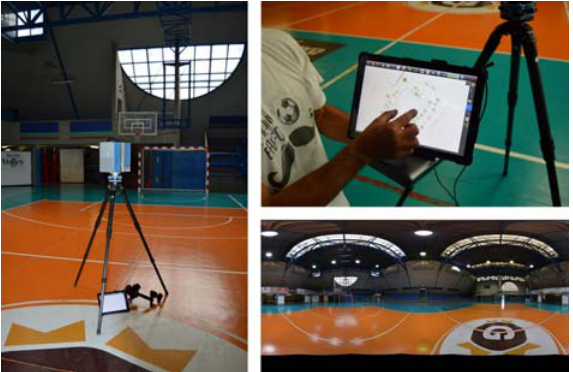
Figure 5 . Scanning with the laser scanner and the spherical images obtained.